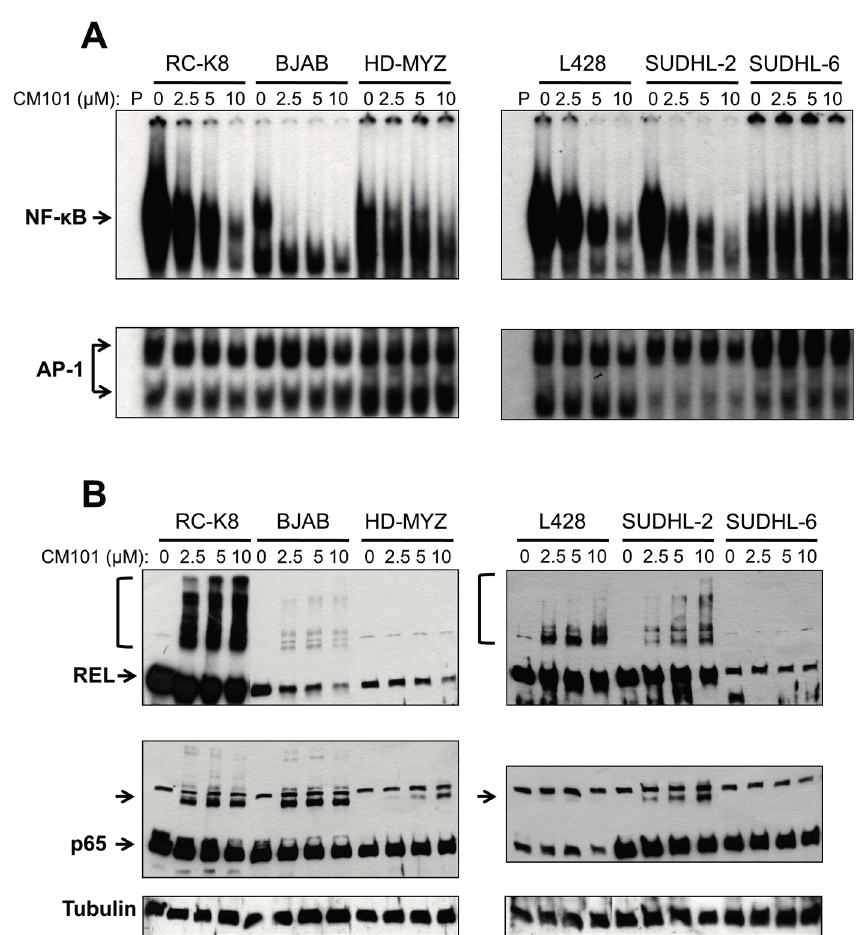
Figure 4. CM101 inhibits REL/NF- κ B DNA binding in sensitive B-lymphoma cell